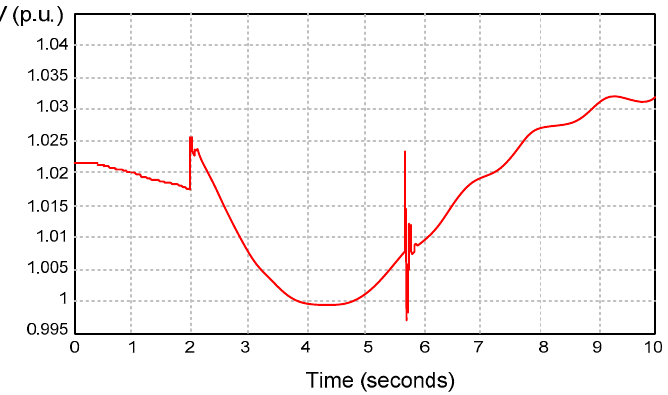
Figure 8. Voltage variation in 400 kV Constanta Nord.